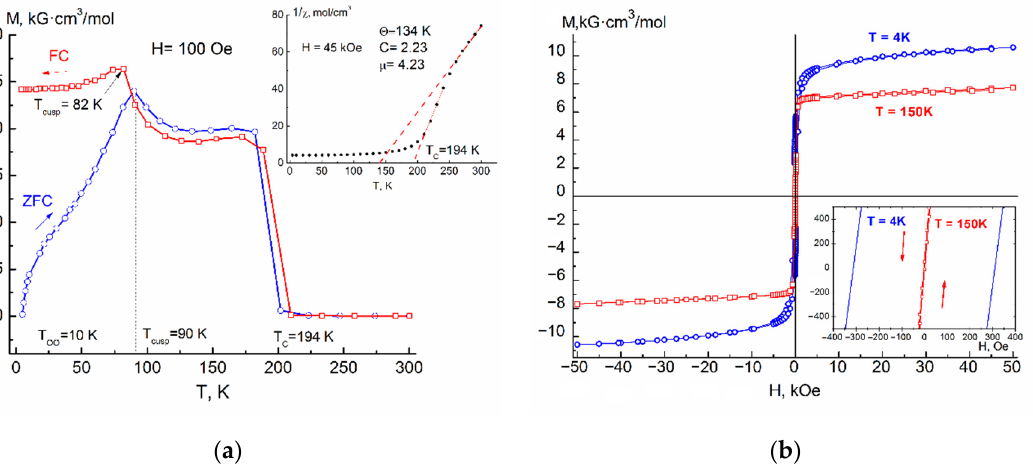
Figure 1. ( a ) Dependences of the M vs. Т of FC and ZFC (M( Т ) ZFC or M( Т ) FC ) magnetization for Fe 0.95 Ag 0.05 Cr 2 S 4 in a 100 Oe field. Inset: dependence of the inverse magnetic susceptibility versus temperature for this composition. ( b ) Dependences of the magnetization versus magnetic field for Fe 0.95 Ag 0.05 Cr 2 S 4 at 4 and 150 K.